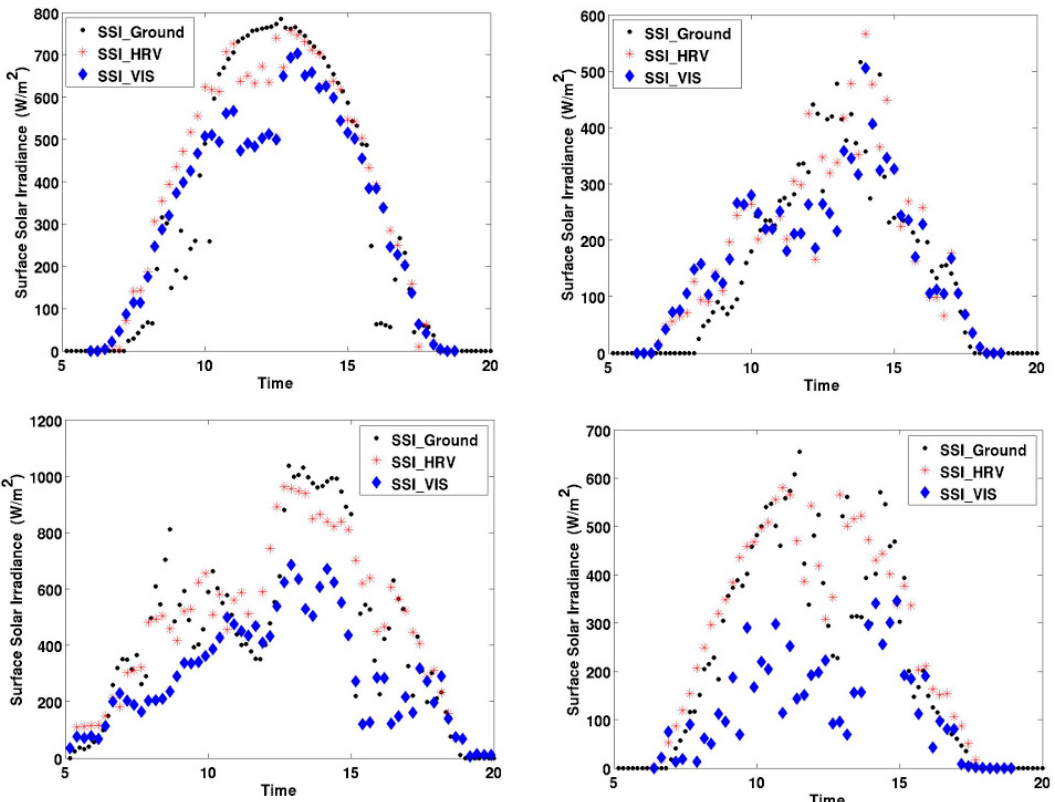
Figure 4. As in Figure 2, but for partially cloudy sky. First row; ( Left column ): 16 March 2018 (Lat = 46.105179, Long = 9.5694208). ( Right column ): 12 March 2018 (Lat = 46.013573, Long = 9.6624260). Second row; ( Left column ): 15 June 2017 (Lat = 45.633198, Long = 9.5564108). ( Right column ): 4 October 2017 (Lat = 45.715240, Long = 9.6892786).